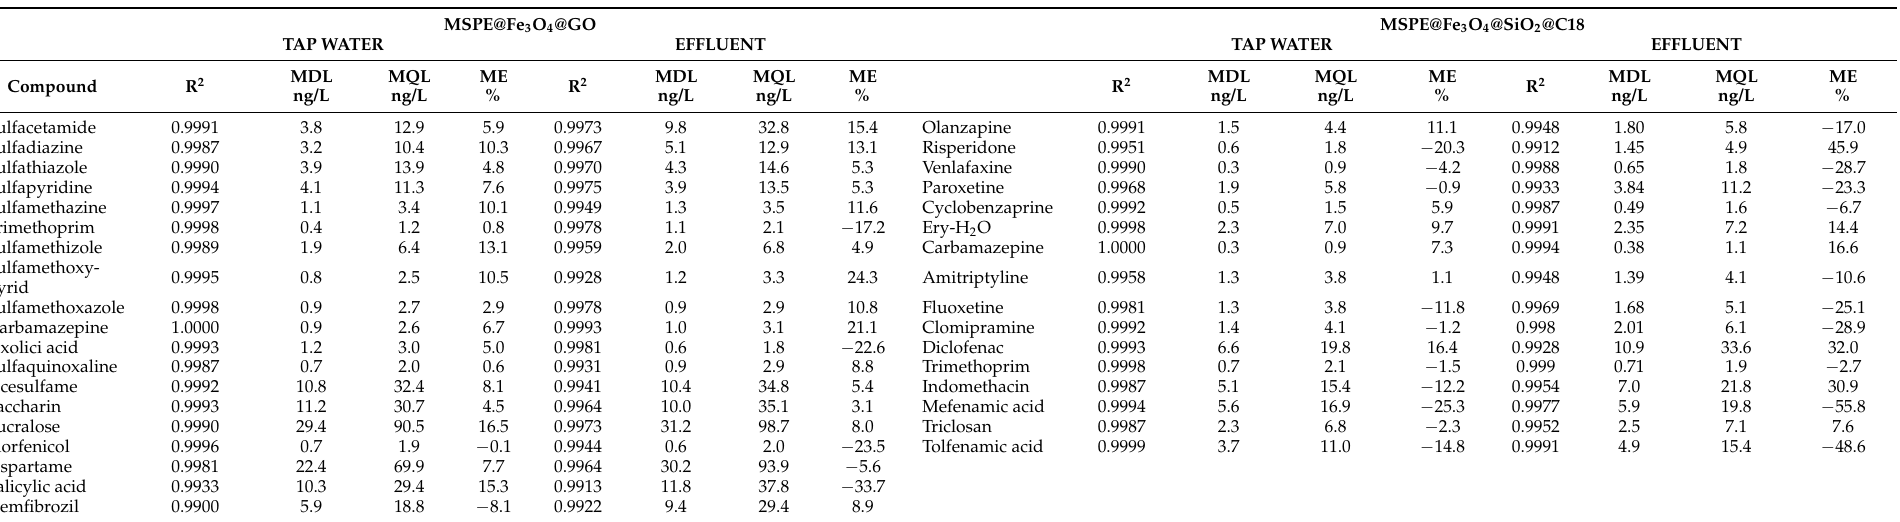
Table 2. Parameters indicating the performance of the analytical methods MSPE-GO, MSPE-C18. Method detection and quantification limits (MDL, MQL), linearity(R 2 ), and matrix effect in all matrices